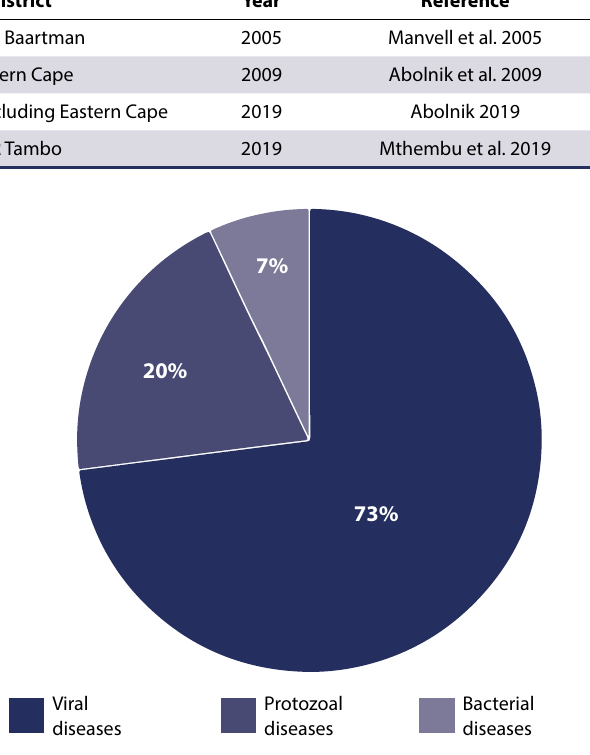
Table II: Poultry diseases identified in the Eastern Cape Province between 2000 and 2020 from all databases from Web of Science Disease